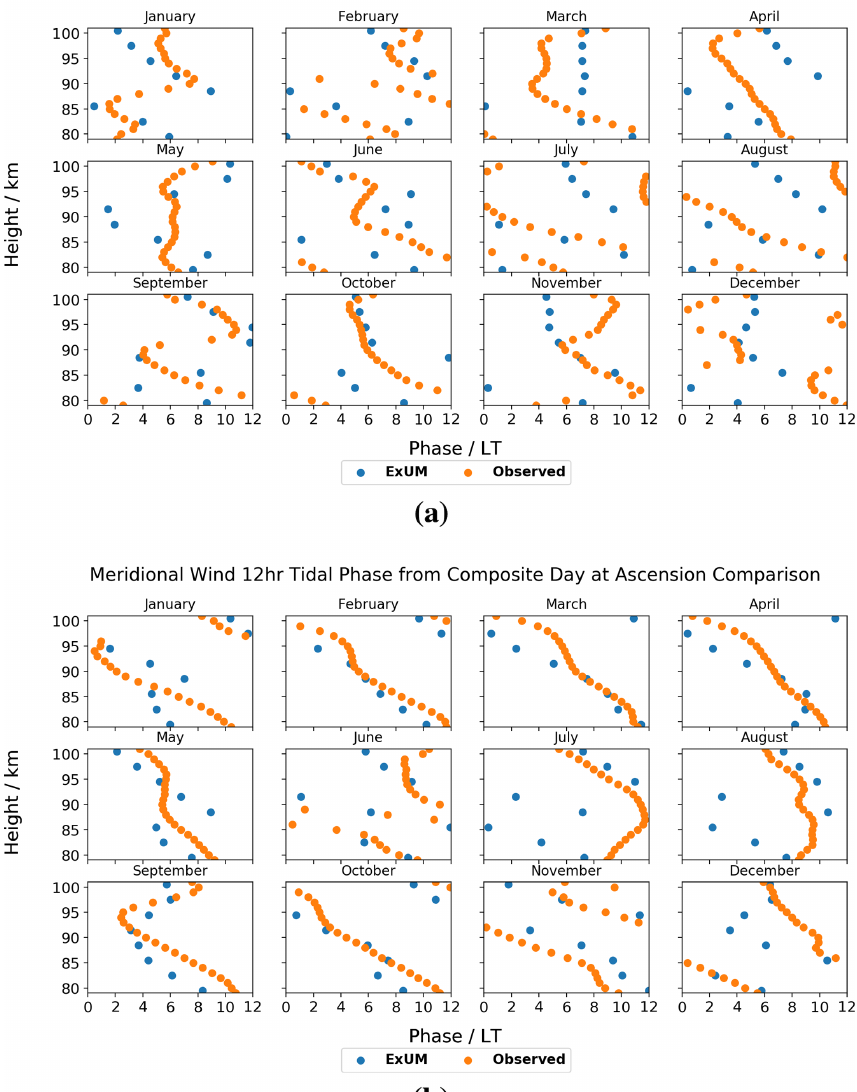
Figure 14. Phases for each month as a function of height for the (a) zonal ( u ) and (b) meridional ( v ) components of the semi-diurnal tide at Ascension Island. Both the phases from the model (blue) and meteor radar (orange) are